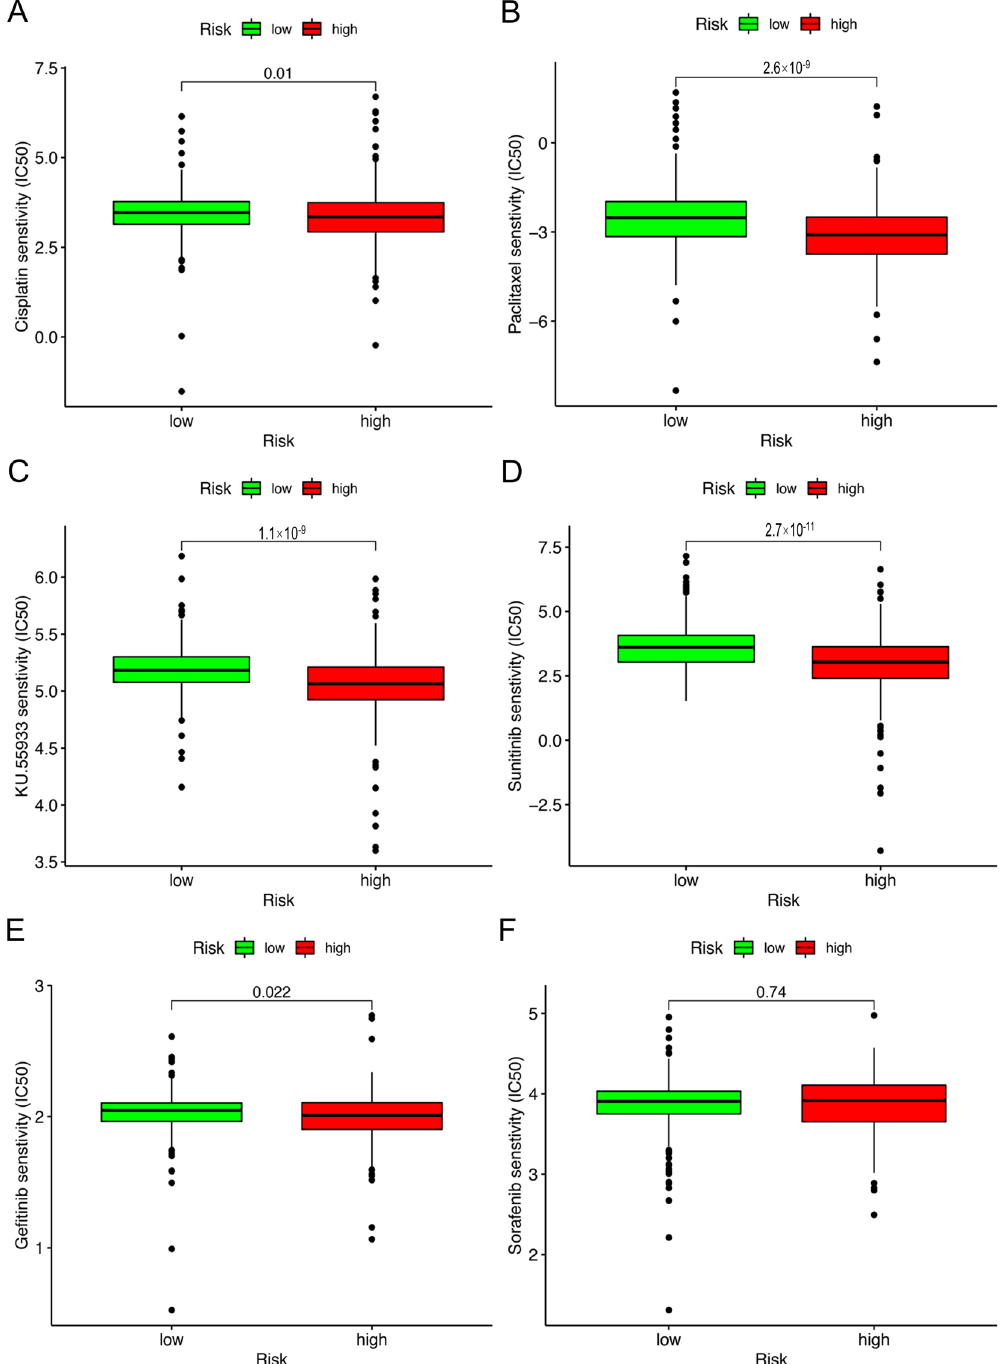
Figure 6. Calculation of the IC50 of KIRC − related drugs using the risk assessment model. The model acted as a potential predictor for chemosensitivity, as high − risk scores were related to a lower IC 50 for chemotherapeutics such as ( A ) cisplatin, ( B ) paclitaxel, ( C ) KU.55933, ( D ) sunitinib, and ( E ) gefitinib. However, ( F ) sorafenib was not statistically significant.